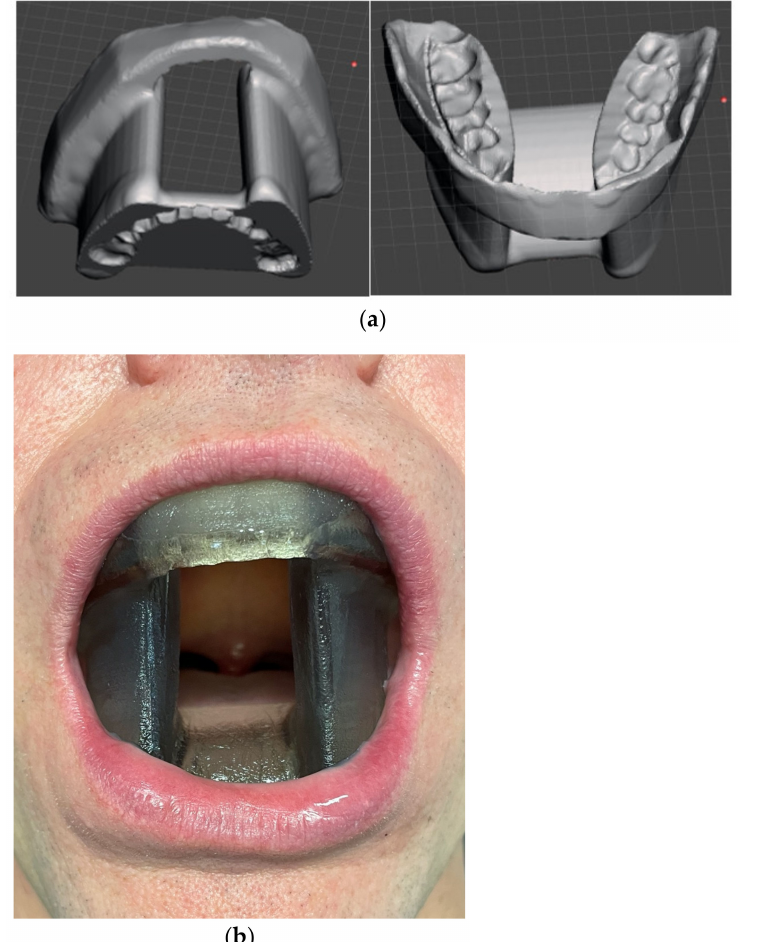
Figure 9. Patient-specific 3D-printed device combining a tongue-depressing radiation stent and buccal retractor: ( a ) CAD construction and ( b ) device installed in the